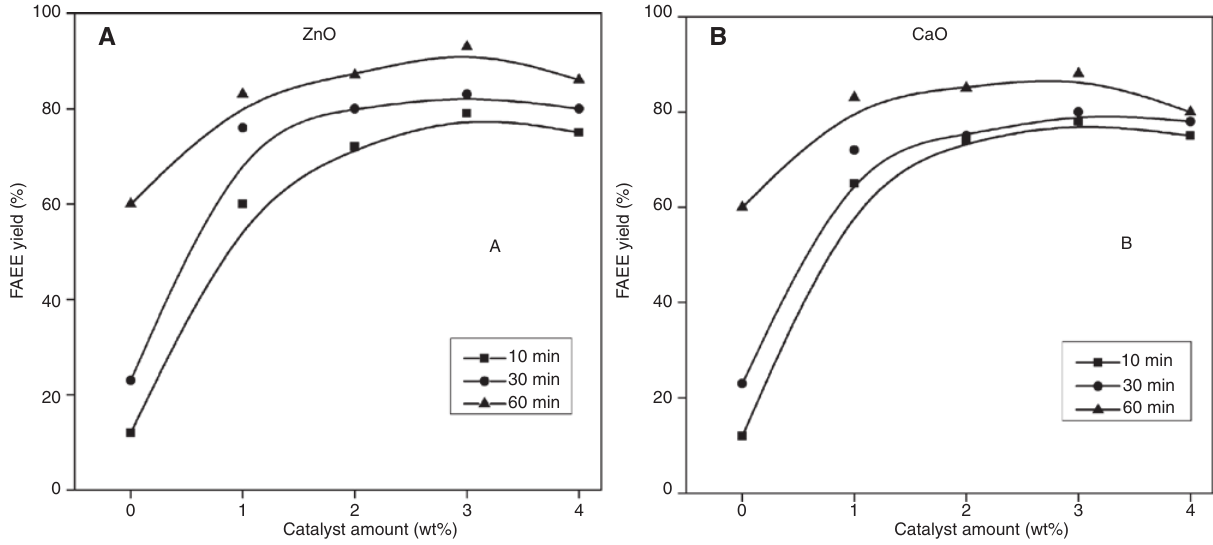
Figure 14: Effect of the catalyst amount of ZnO (A) and CaO (B) at reaction conditions: temperature 270 ° C, molar ratio 42/1.